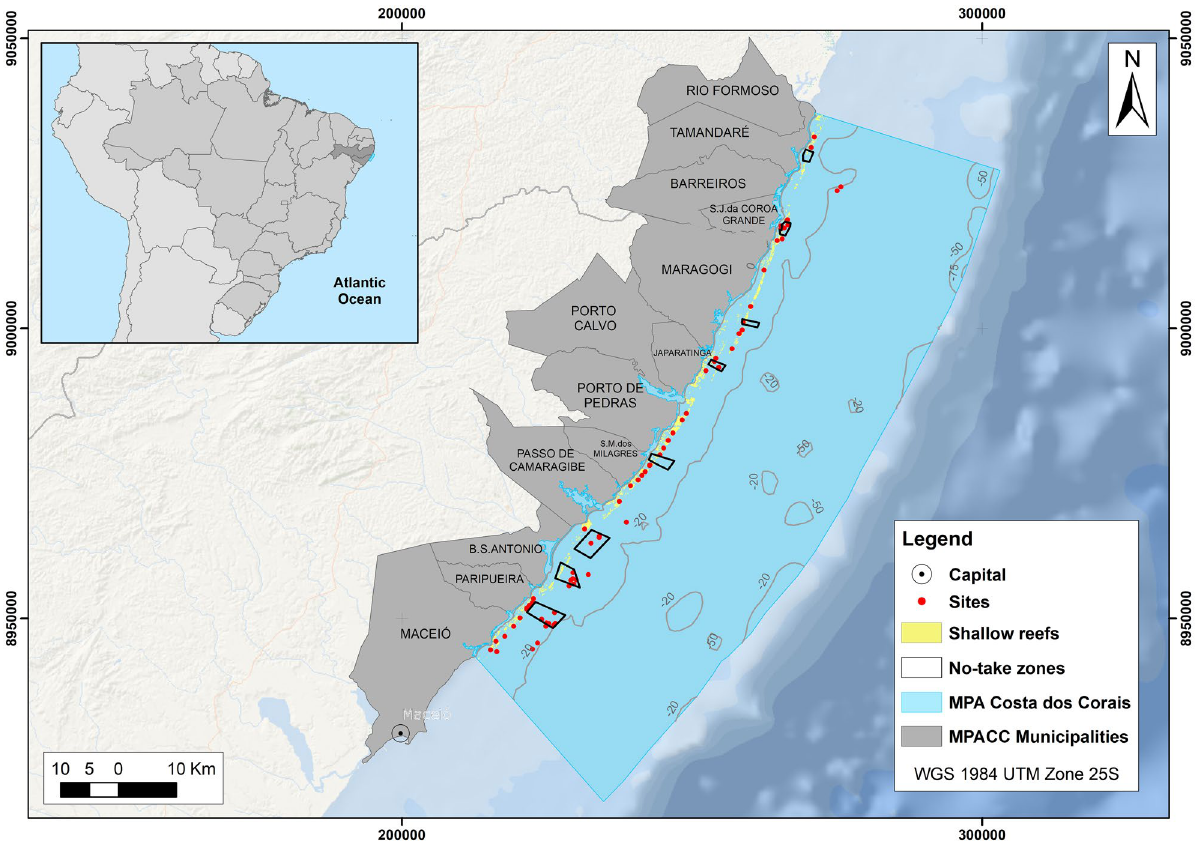
Figure 6. – Map of MPA Costa dos Corais highlighting the 94 sampling sites where field data for parrotfish species was collected. Figure elaborated by the authors using Arcgis